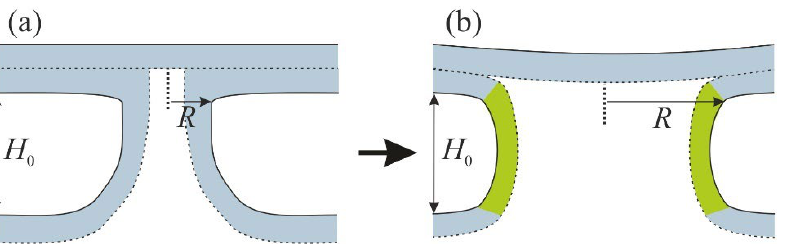
Figure 3. Schematic representation of the π -shaped structure model. ( a ) Origination of the π -shaped structure after stalk formation. ( b ) Expansion of the π -shaped structure; transition zones between the fusing membranes are colored in green. Other parts of the lipid membrane are highlighted in blue. R is the structure radius; H 0 is the fixed distance between the membranes.